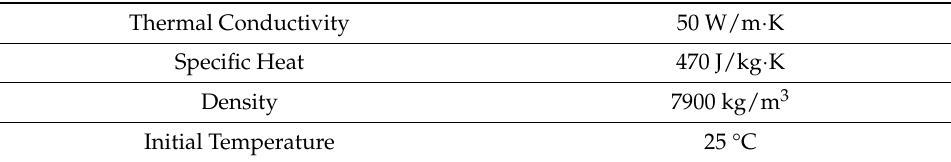
Table 1. The material properties of S275